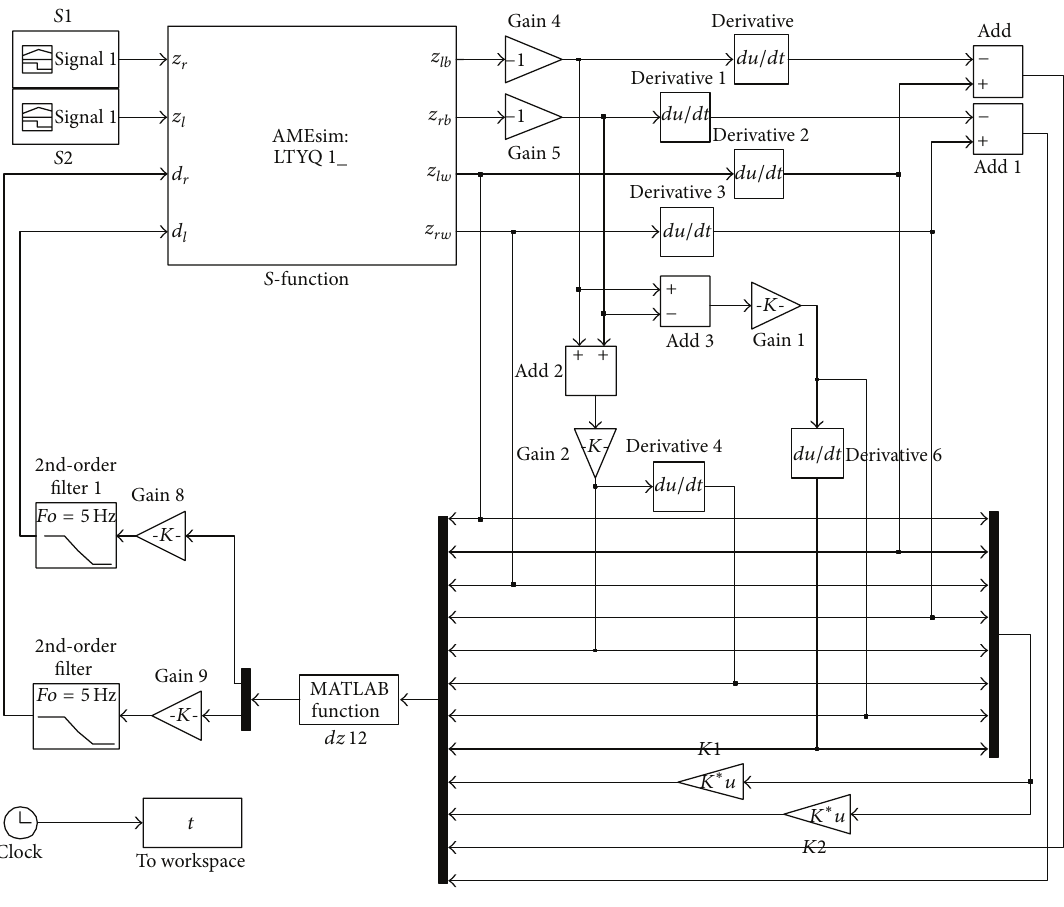
Figure 3: MTLAB/Simulink simulation model.